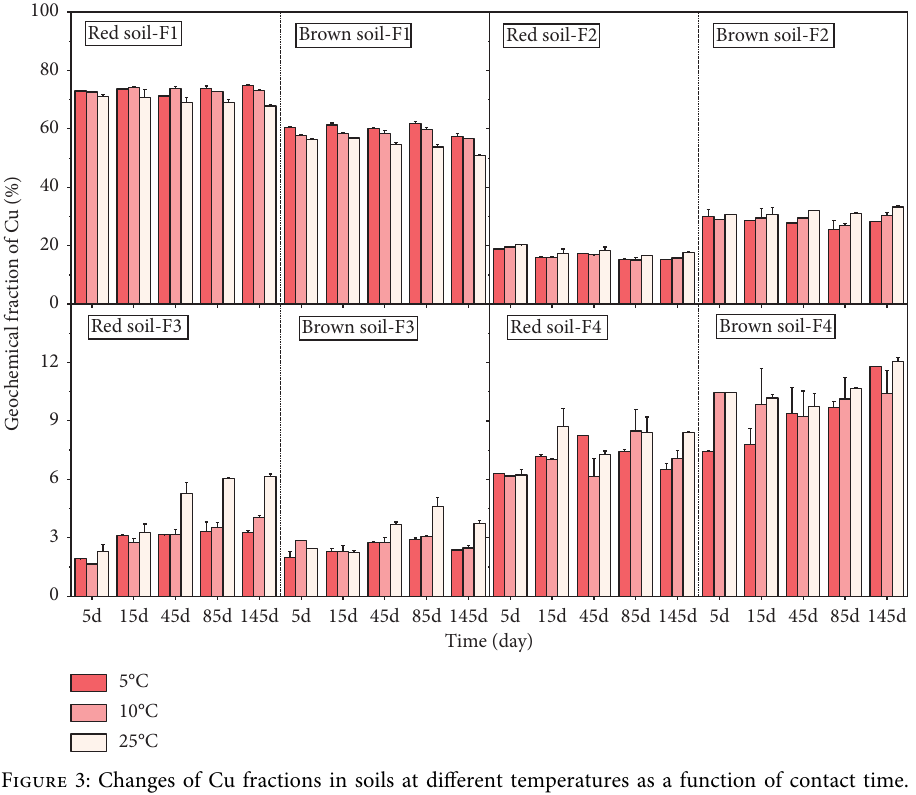
Figure 3: Changes of Cu fractions in soils at different temperatures as a function of contact